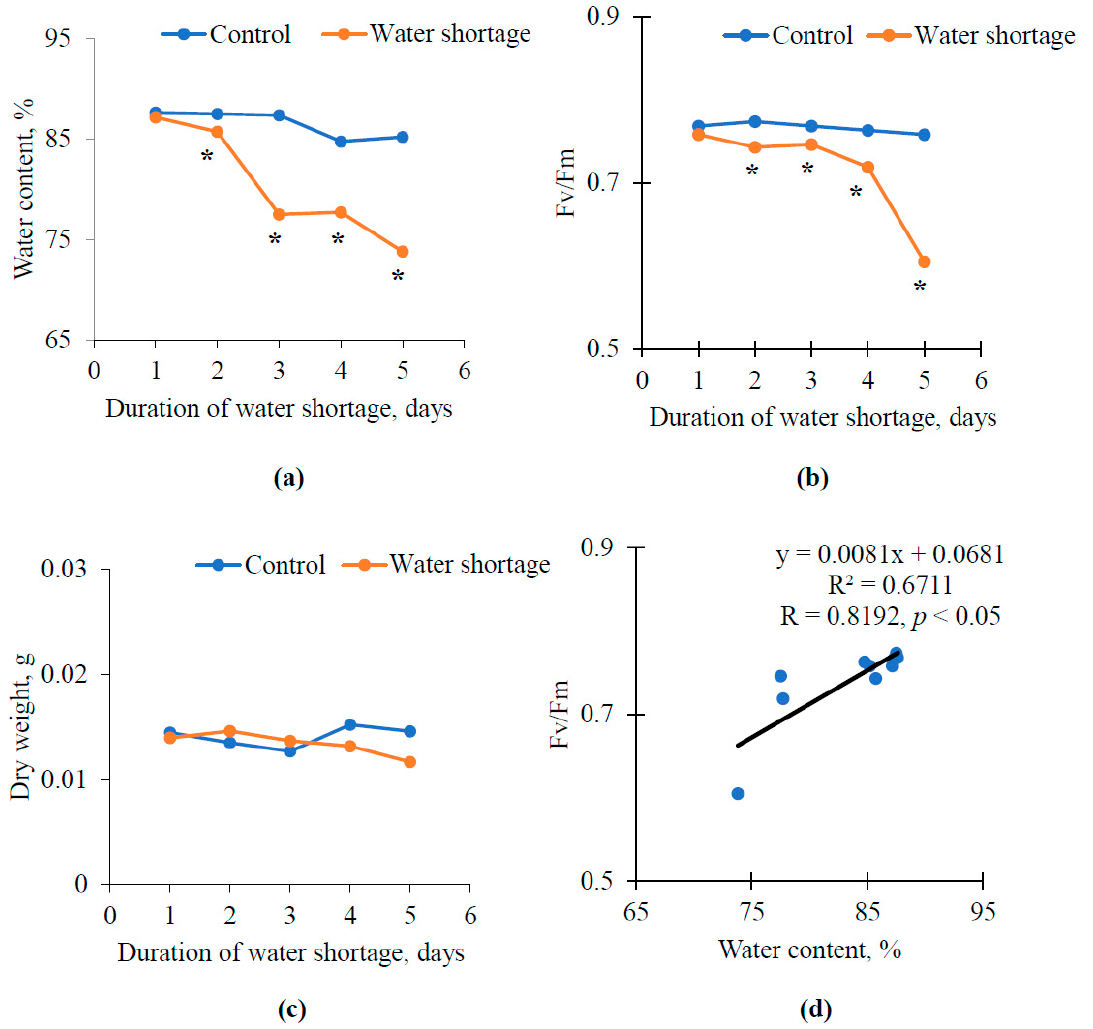
Figure 2. Dynamics of the relative water content ( a ), photosynthetic maximal quantum yield (Fv/Fm) ( b ), and dry wight ( c ) in leaves of pea seedlings subjected to the water shortage and a scatter plot between the relative water content and Fv/Fm ( d ). The relative water content and dry wight were calculated per leaf. Control plants were irrigated every two days, irrigation was not used for five days in experiment. R 2 and R are determination and correlation coefficients. Medians are shown in the figure. * Value significantly differed from control ( p < 0.05, Mann–Whitney U test).